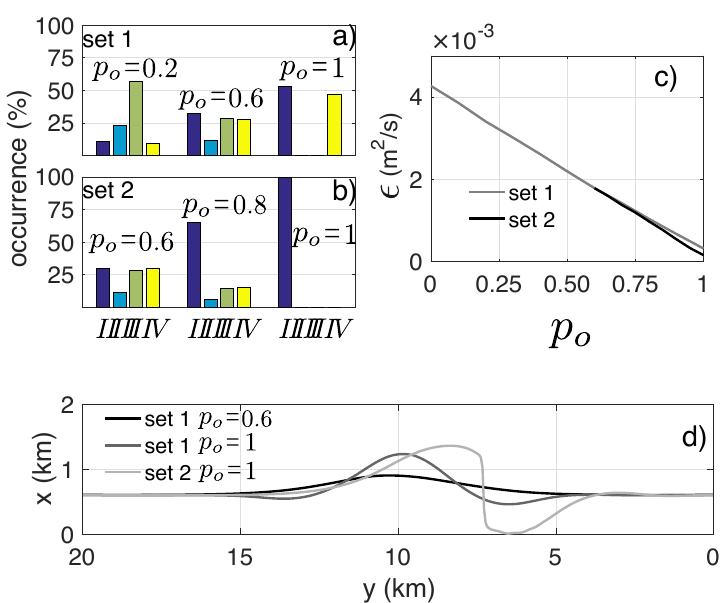
Figure 5. Probability of occurrence of each wave sectors for varying high-angle wave frequency, p O , for: ( a ) bimodal conditions assuming that both Sectors I and IV are modified proportionally; and ( b ) unimodal conditions assuming that only the probability of occurrence of Sector I increases. Averaged diffusivity over the last five years of simulations as a function of high-angle wave frequency ( c ). Shorelines after 50 years of evolution for the indicated simulations ( d